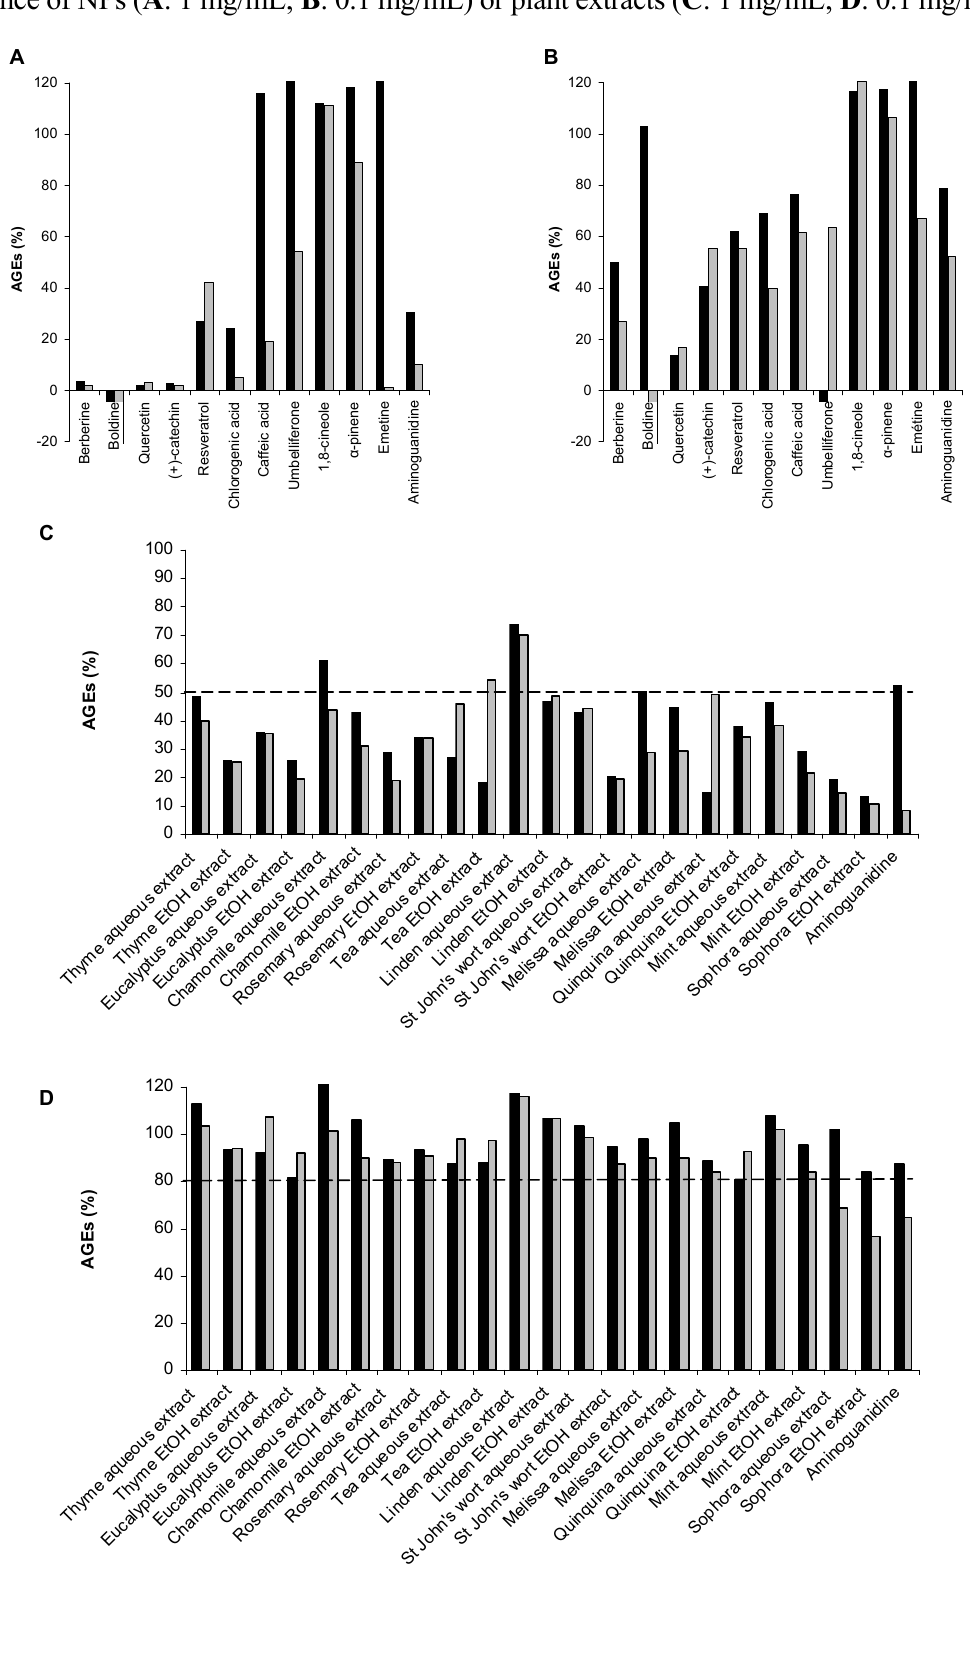
Figure 4. Vesperlysines-like (black) and pentosidine-like (grey) AGE formation in the presence of NPs ( A : 1 mg/mL; B : 0.1 mg/mL) or plant extracts ( C : 1 mg/mL; D : 0.1